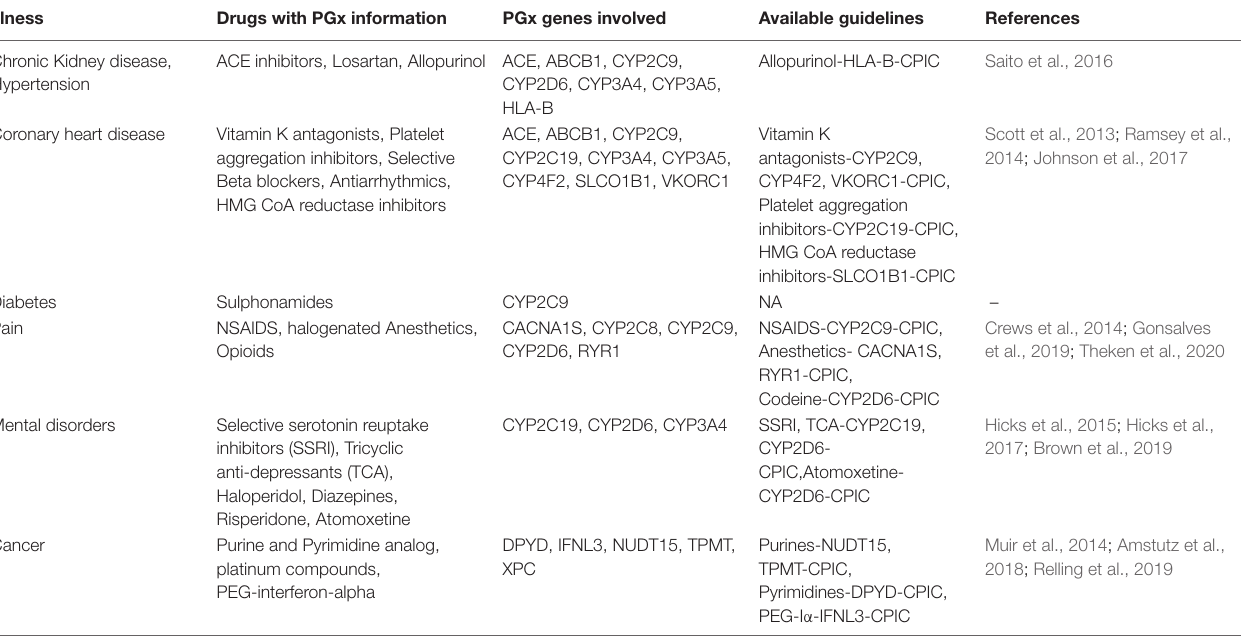
TABLE 1 | Chronic diseases in Australian indigenous